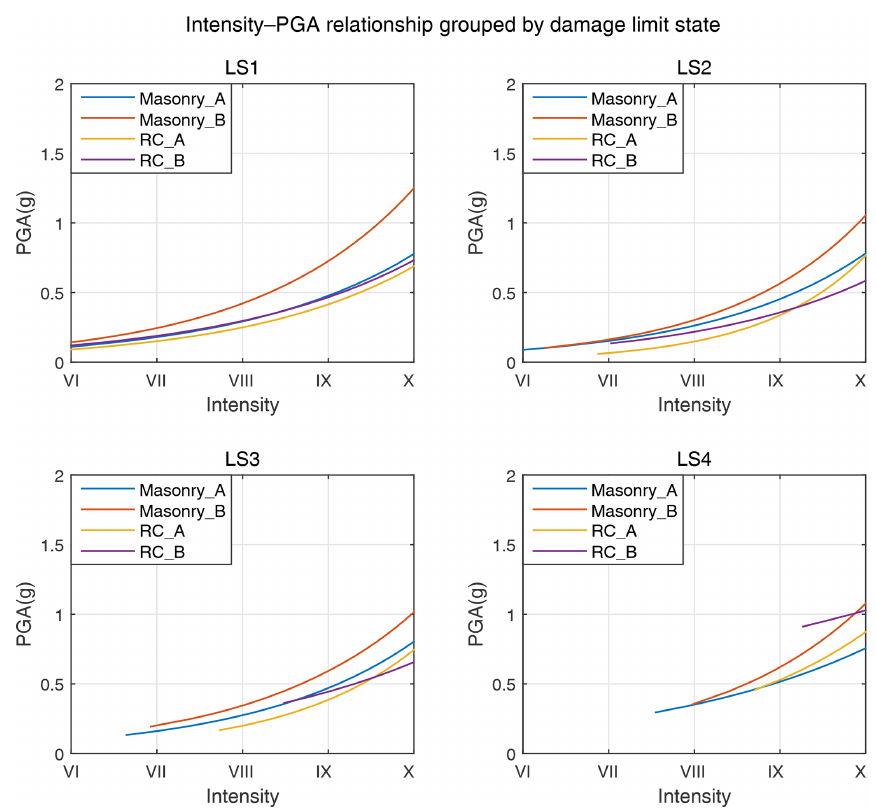
Figure 10. Intensity–PGA relations grouped by damage limit states. Only intensity and PGA values with truncated exceedance probability ≥ 1% for each damage limit state of each building type are plotted, since higher damage states can appear only for higher intensities or PGA values (see Sect. 5.2 for more